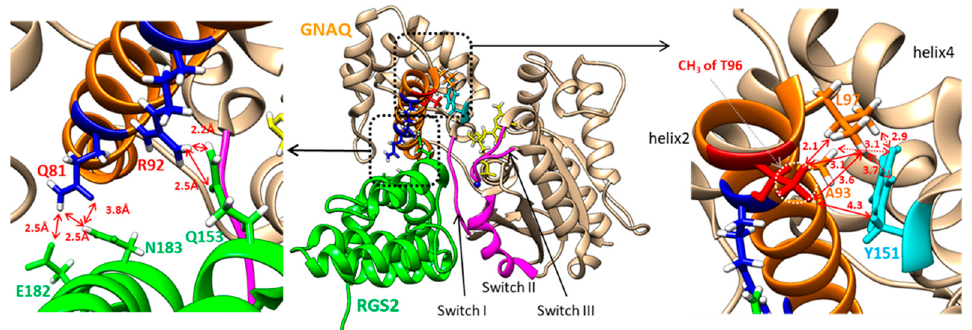
Figure 5. The complex structure (PDB ID: 4EKD) of GNAQ (tan) and RGS2 (green). The regions of Switches I–III are depicted in pink. Helix 2 of GNAQ is colored in orange. The dotted rectangles in the center are enlarged in the left or right panels. The left panel shows the hydrogen bonding network between the helical domain of GNAQ and RGS2. The identification of hydrogen bonding was calculated using the software University of California, San Francisco (UCSF) Chimera. The right panel shows the hydrophobic network between helix 2 and helix 4 of GNAQ. The side chain of T96 is depicted in red. The side-chain atoms of Tyr151 are shown in cyan. The solid-line arrows represent the distances between the methyl protons of T96 and the other atoms. The dotted line arrows show the distance between the side chain of Tyr151 and the side chain of Ala93 and Leu97. The distance unit, Å, is removed for clear